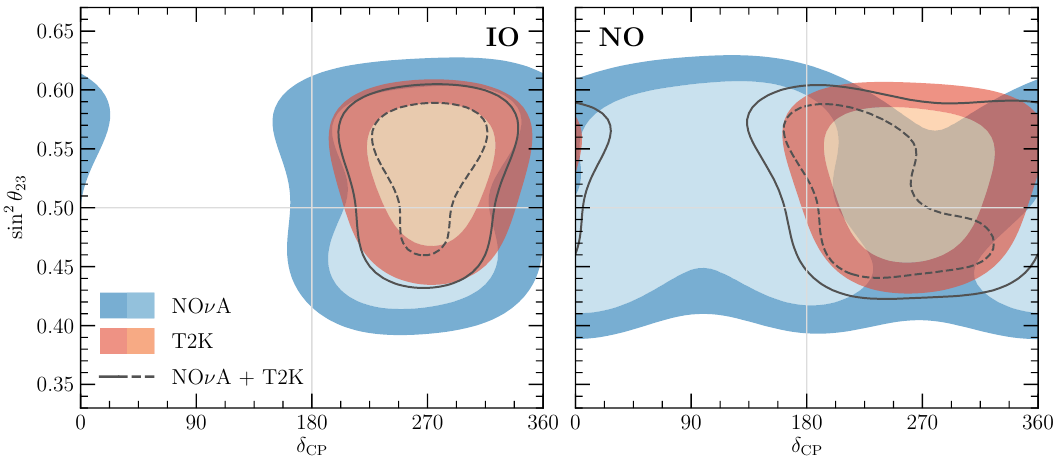
Figure 3 . 1 (cid:27) and 2 (cid:27) allowed regions (2 dof) for T2K (red shading), NOvA (blue shading) and their combination (black curves). Contours are de(cid:12)ned with respect to the local minimum for IO (left) or NO (right). We are (cid:12)xing sin 2 (cid:18) 13 = 0 : 0224, sin 2 (cid:18) 12 = 0 : 310, (cid:1) m 2 minimize with respect to j (cid:1) m 2 j 3 ‘